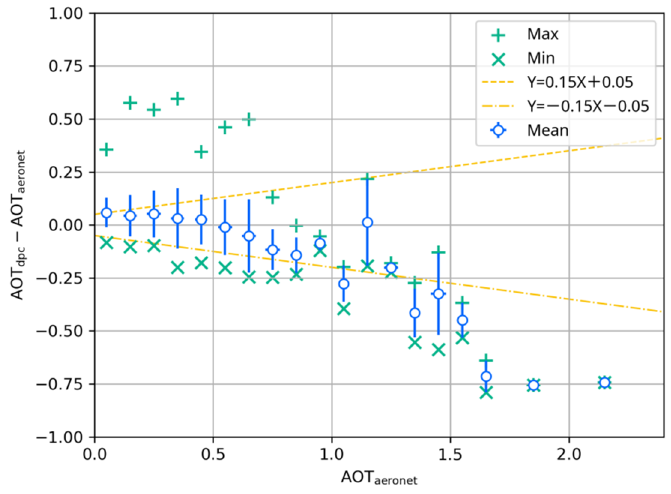
Figure 6. Same as Figure 3 but for the fine mode AOD.